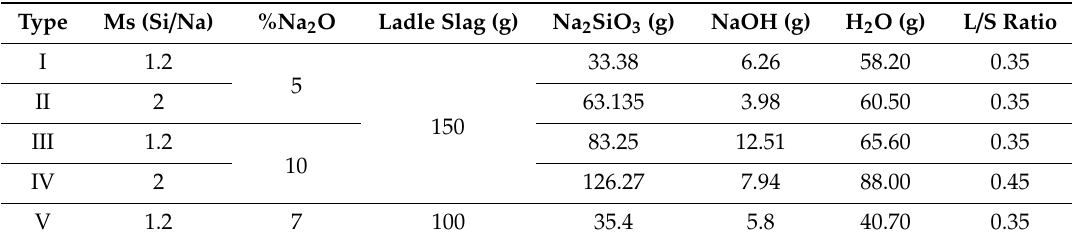
Table 3. Dosage of the pastes to define the activation parameters.